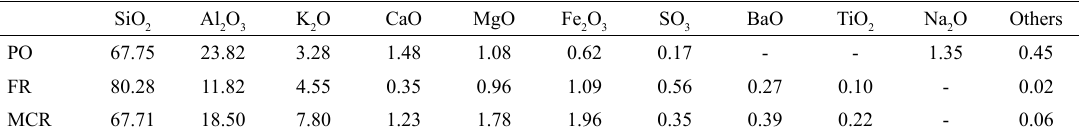
Table 2. Chemical composition of the raw materials (%): Ceramic mass for porcelain tile (PO); Fine quartzite residue (FR); Milled coarse quartzite residue (MCR). SiO Al O K 2 2 3 2